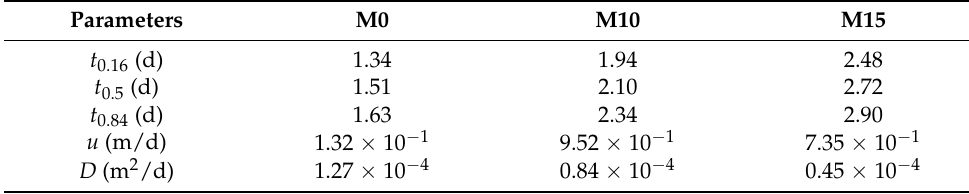
Figure 7. Relative concentration breakthrough curves of sulfate ions. Table 2. u and D of M0, M10, and